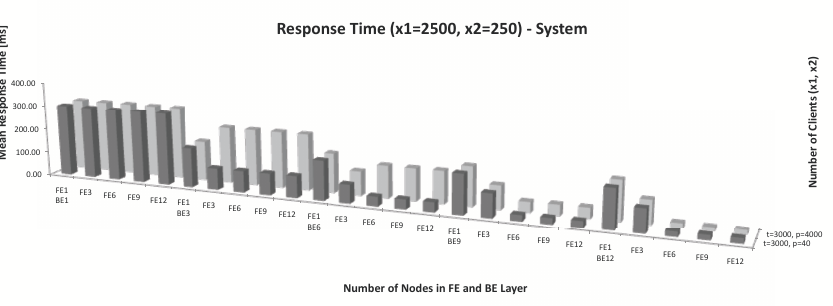
Figure 8. Response time for x 1 = 2500 clients, 3000 threads per FE node, 4000 process per BE node.